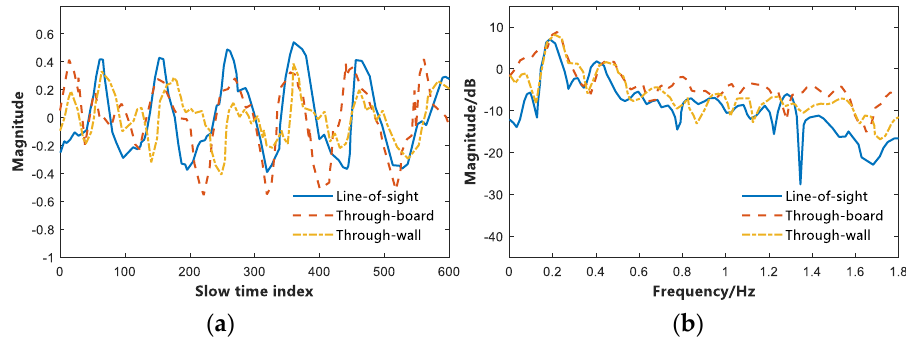
Figure 9. Time domain and frequency domain diagram of penetration through different media. ( a ) Time domain of penetrating different media. ( b ) Frequency domain penetration of different media.